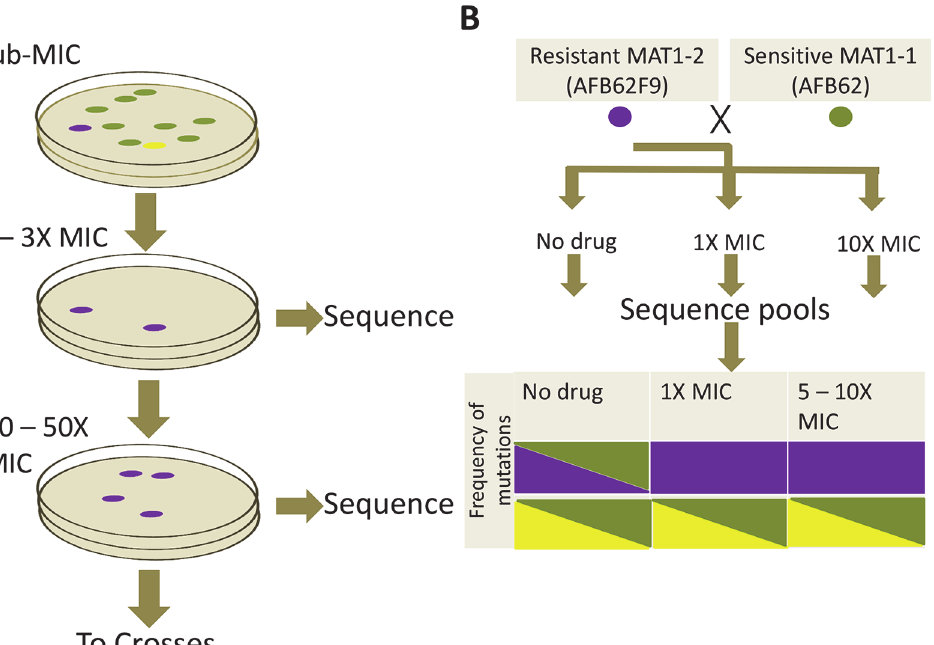
Fig 4. Azole resistance experimental design. (A) Sensitive AFB62 or AFB62F9 cells were incubated on solid media containing sub-MIC concentrations of each of itraconazole, voriconazole, or posaconazole. Resulting spores were plated on selective media with at least 1X MIC of each antifungal to obtain fewer than 100 colonies. Three resistant colonies (purple) from each selective plate were subsequently and independently plated on highly selective plates containing 10 – 50X MIC of each antifungal. Three highly resistant strains (purple) were selected for sequencing and for sexual crosses. (B) Each of the highly resistant isolates from (A) was crossed with the sensitive isogenic strain of the opposite mating type. Ascospores from selected crosses were grown on media with no drug, 1X MIC and 10X MIC of the drug and their DNA sequenced to identify resistance allele frequencies. Mutant alleles are depicted in purple and yellow reference alleles in green. Cells filled with a single color represent an allele frequency of 1, cells with two colors represent an equal proportion of mutant and reference alleles. The purple mutation shows the expected frequencies for an allele associated with resistance, while the yellow mutation shows an expected frequency for alleles not associated with